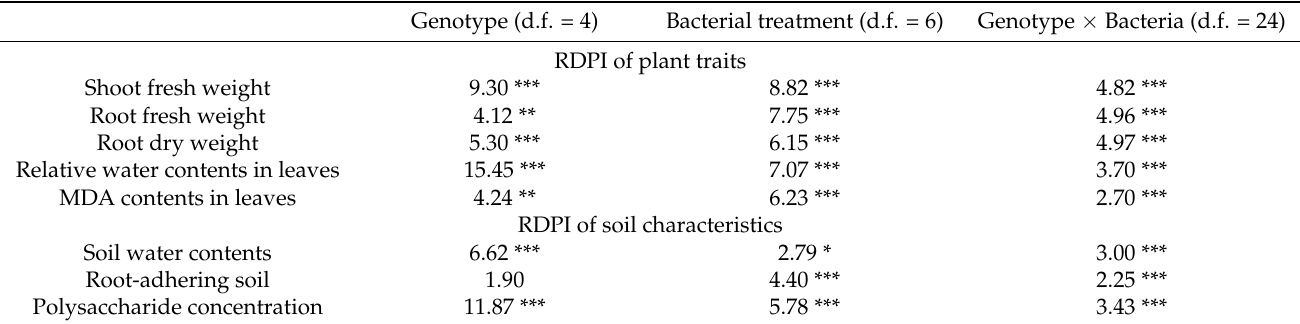
Table 1. Results of analysis of variance comparing relative distance plasticity index (RDPI) among plant genotypes in response to bacterial treatments under drought conditions. F ratios are